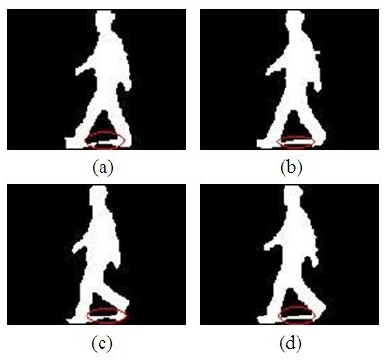
Fig. 4. Four images with imperfect